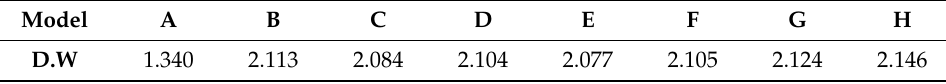
Table 9. Results of the Durbin–Watson test for each prediction regression model.